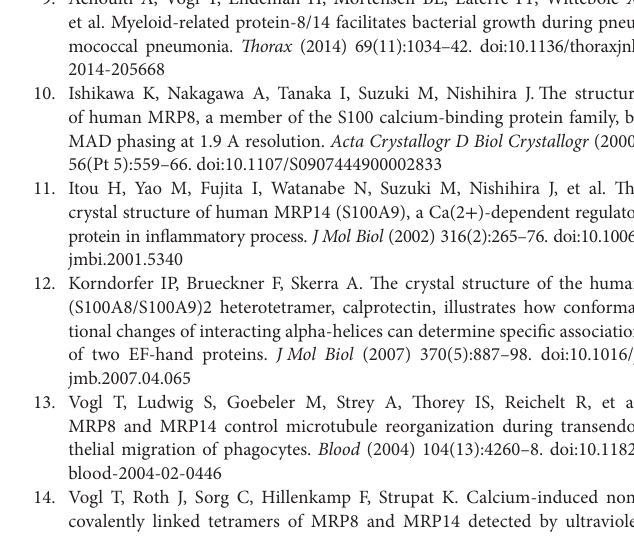
FigUre s1 | Characterization of the purification process and culture of alveolar epithelial cells (AECs). (a) Cells were stained at the end of the purification process by flow cytometry for leukocyte markers like CD45, CD16-32, and CD34. Solid histograms depict isotype controls, open histograms depict CD45/ CD16-32/CD34 staining. (B) AECs were grown in DMEM with 10% FBS [DMEM (10% FBS)] or in airway epithelial media (without FBS) for 3 days and the media collected after 3 days was analyzed for IL-6 secretion by enzyme-linked immunosorbent assay. (c) Primary AECs were stained for pro-SPC (FITC) immediately after isolation by flow cytometry. Solid histogram depicts isotype control, open histogram depicts pro-SPC staining. proSP-C = Prosurfactant protein C, FITC = Fluorescein isothiocyanate. FigUre s2 | Stimulation of human monocytes and AECI with lipopolysaccharide (LPS) or S100A8. (a) Human monocytes were stimulated with different concentrations of LPS, or murine S100A8 (5 µg/ml) in presence and absence of Polymyxin B (25 µg/ml) for 4 h. TNF- α release was measured by enzyme-linked immunosorbent assay (ELISA). (B) Confluent monolayers of AECI were stimulated for 6 h with different concentrations of LPS or murine S100A8 (5 µg/ ml). Polymyxin B (25 µg/ml) was added in combination with LPS (10 ng/ml) or S100A8 (5 µg/ml). IL-6 release was measured by ELISA. FigUre s3 | TLR4-MD-2 expression in AECII stimulated by murine S100A8 or lipopolysaccharide (LPS) in presence of Polymyxin B. WT AECII were cultured for 1 day, and then stimulated by murine S100A8 (5 µg/ml) or LPS (10 ng/ml) alone or in combination with Polymyxin B (25 µg/ml) for 6 h, followed by staining for TLR4-MD-2 (Streptavidin Dylight 488). Nuclei were stained with DAPI. Imaging was performed by an inverted fluorescent microscope (Axio Observer, Zeiss), n = 3 experiments and a representative image is shown. Scale bar is 50 µm. FigUre s4 | Western blot of bone marrow cells of WT and S100A9 KO mice. Bone marrow cells were isolated from three WT and S100A9 KO mice and lysed for western blot staining. Rabbit polyclonal S100A8 and rabbit polyclonal S100A9 antibodies were used for the staining. β actin was used as a positive control for western blot. Imaging was performed by a ChemiDoc Gel Imaging